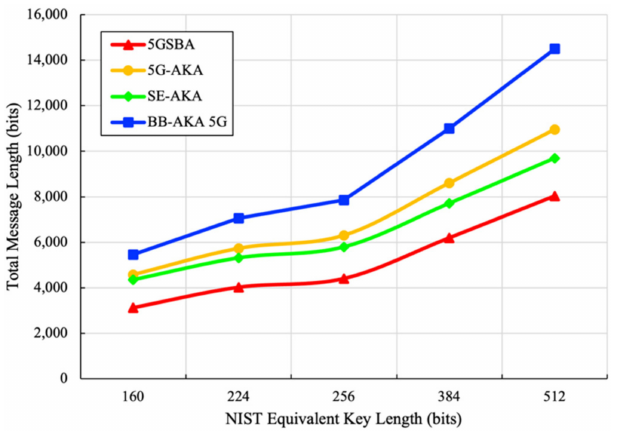
Figure 7. Total bandwidth